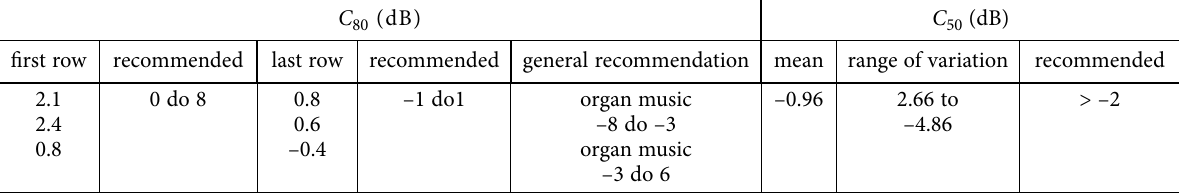
Table 8. Values of acoustic parameters C 80 and C 50 obtained in the simulation after acoustic treatment including recommended values C 80 (dB) C 50 (dB)